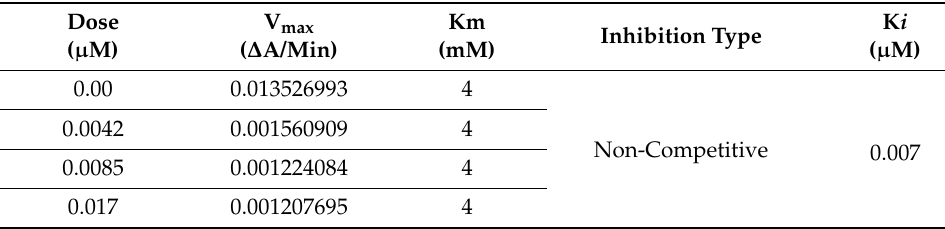
Table 2. Kinetic parameters of the jack bean urease for urea activity in the presence of different concentrations.